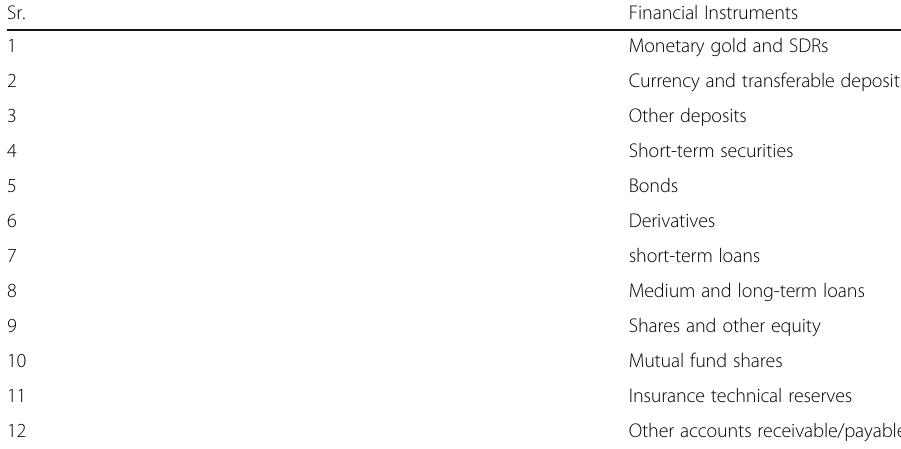
Table 4 Flow accounts assigned to financial assets and liabilities